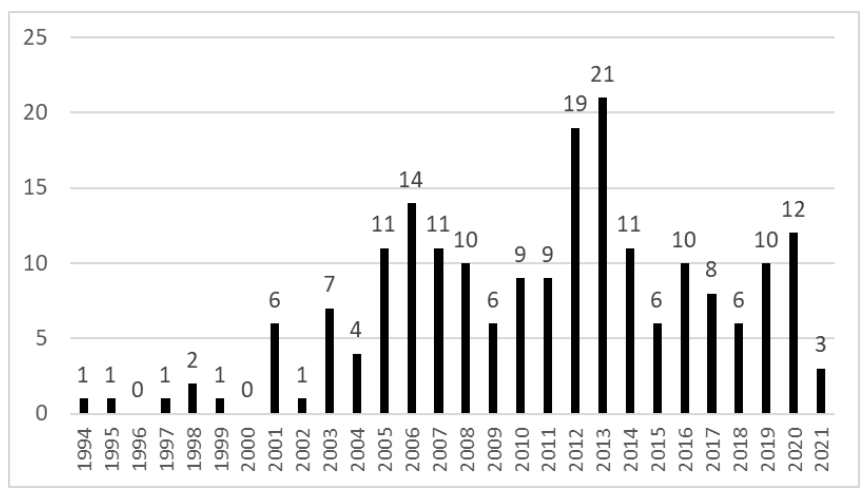
Figure 1. Number of publications on the subject of business improvement districts, per year. Source: author (2021).